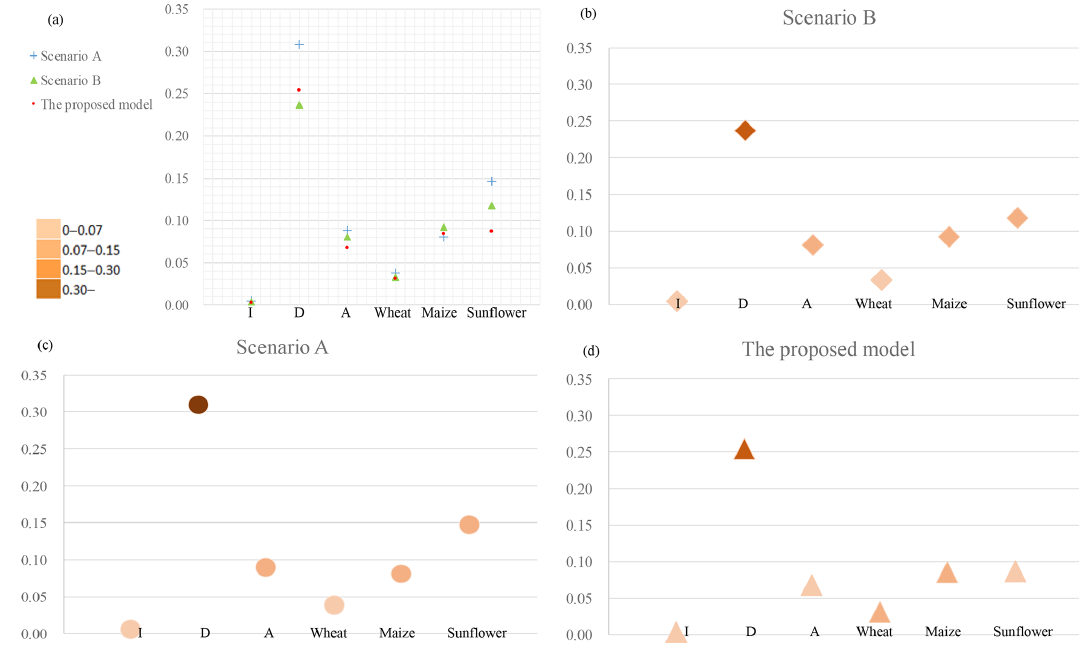
Figure 7. Water stress comparisons. (a) Total water stress; (b) Scenario B water stress; (c) Scenario A water stress; (d) water stress in the proposed model (I: industrial sector, D: domestic sector, A: agricultural